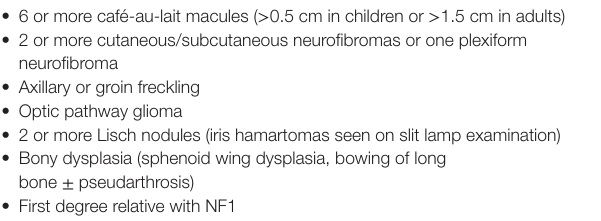
TABLe 3 | Diagnostic criteria for neurofibromatosis 1 (NF1)